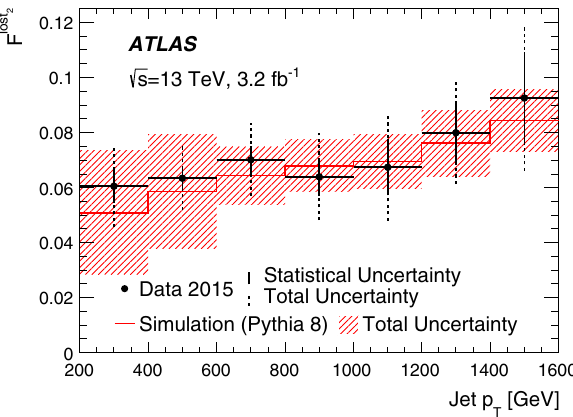
Fig. 17 The measured fraction of lost tracks, F lost 2 , in the jet core ( (cid:7) R (jet,trk) < 0 . 05) as a function of jet p T for data (black circles) and simulation (red line). Vertical solid error bars indicate statistical uncertainty, while the total uncertainty is represented by dashed error bars for data and a shaded area for